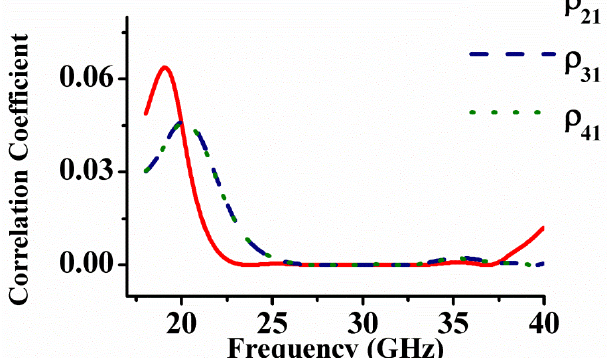
Figure 5: ECC of the proposed antenna when fed through Port 1.